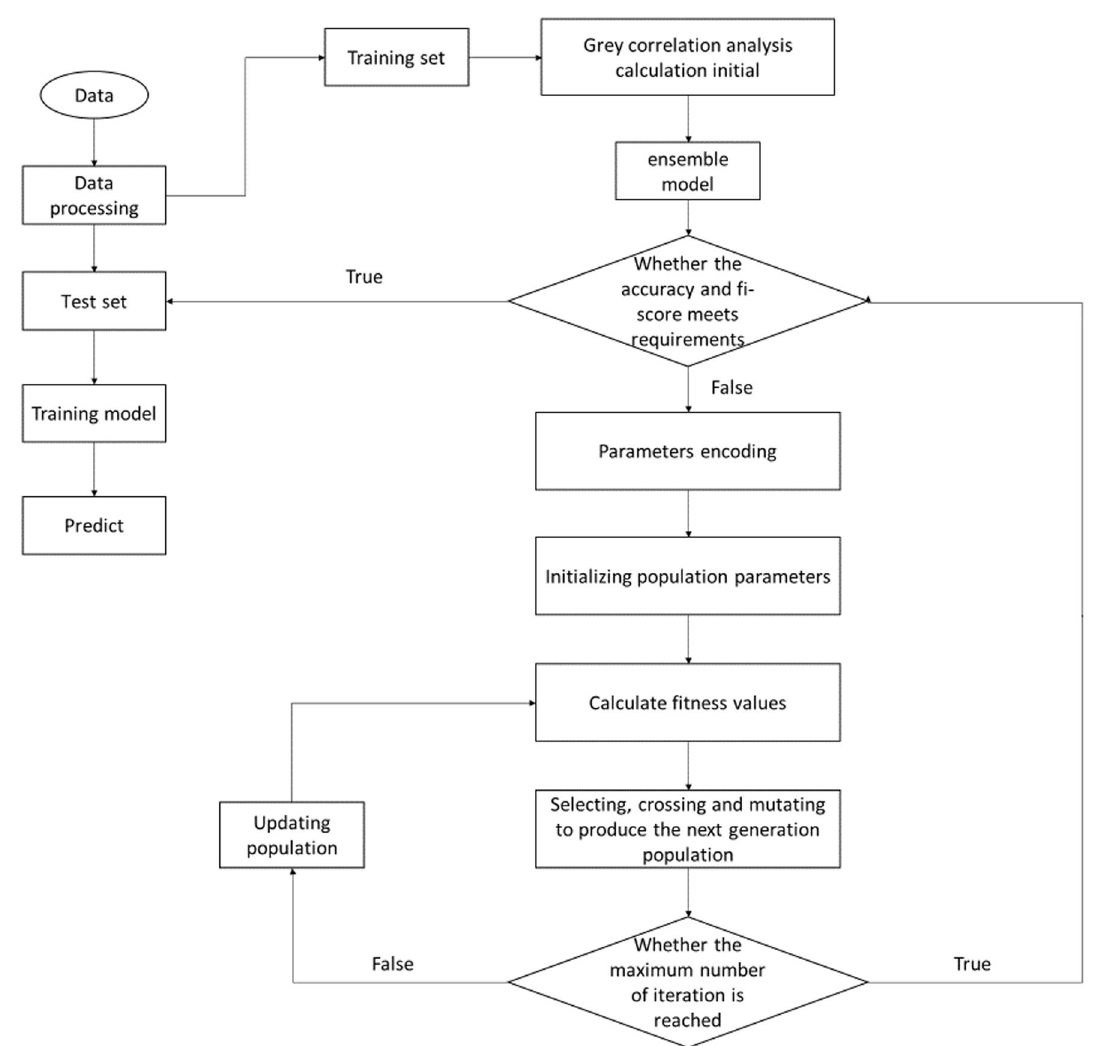
Fig. 1 Calculation steps of the ensemble